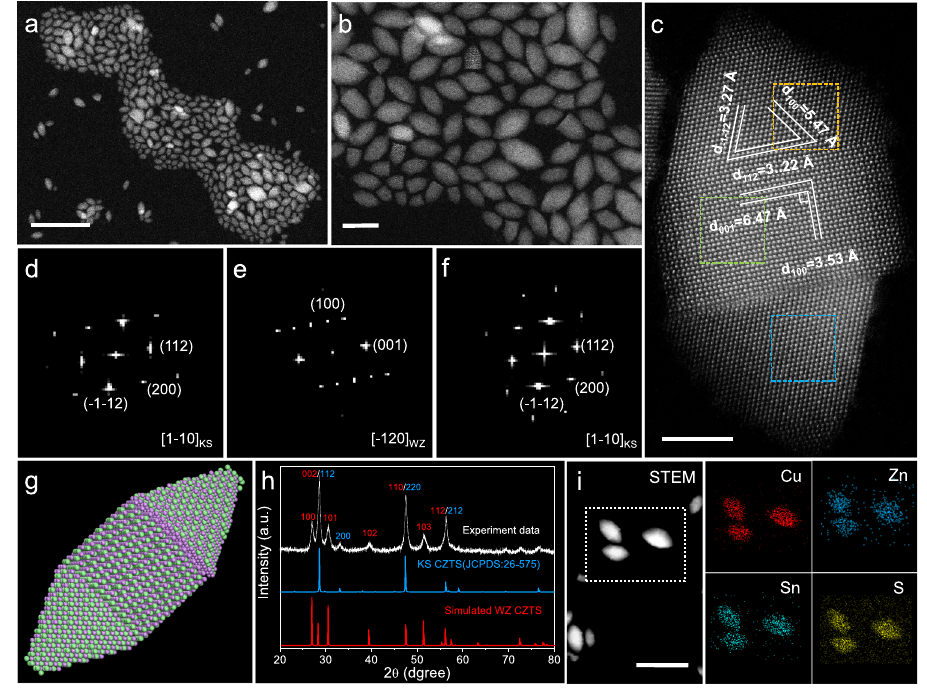
Fig. 2 | Characterization of the double-homojunction polytypic CZTS nanocrystals. Low-magni fi cation HAADF-STEM ( a ) and high-magni fi cation HAADF-STEM ( b ) images. c A representative aberration-corrected high-resolution HAADF-STEM image. FFT patterns of the corresponding orange ( d ), green ( e ) and